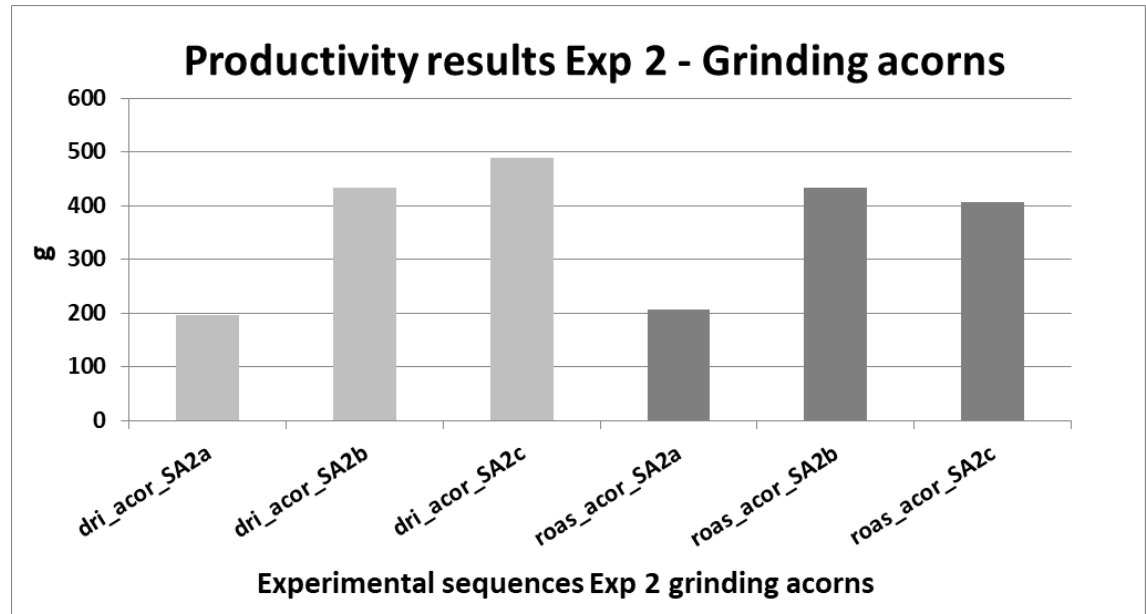
Figure 10. Results of Experiment 2 – grinding dried and roasted acorns. Note: All sequences performed with SA2 tool type. Times in all experimental sequences are stable: a= 60 min; b=120 min; c =120 min.